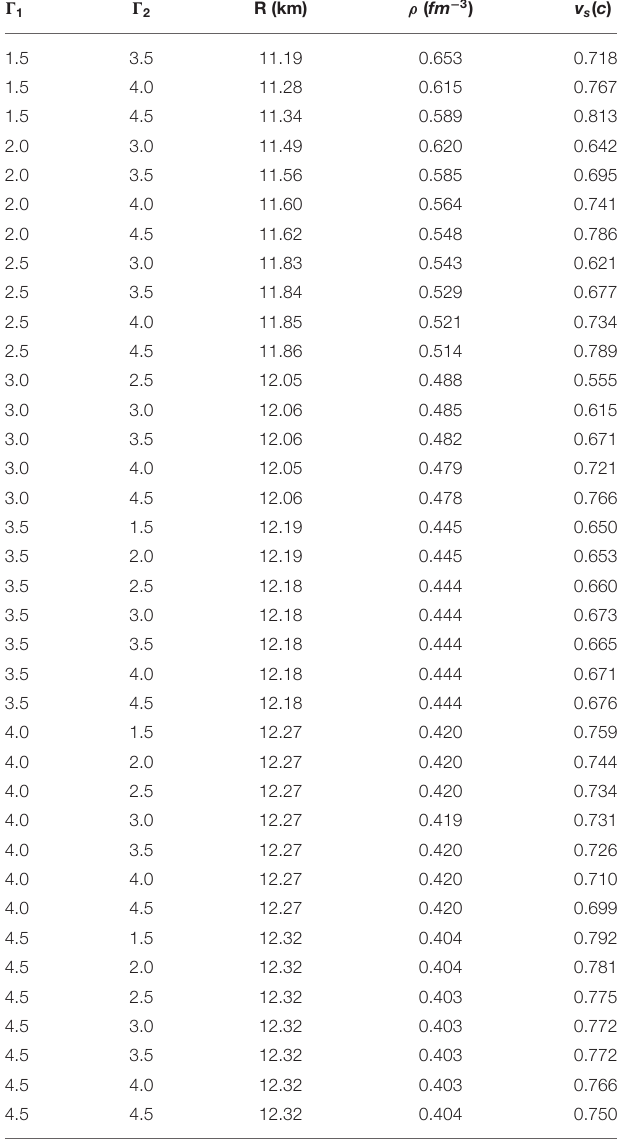
TABLE 6 | Adiabatic indices, Ŵ 1 and Ŵ 2 , of the polytropes attached at the two matching densities, followed by the radius and the central density of the 1.4 M ⊙ neutron